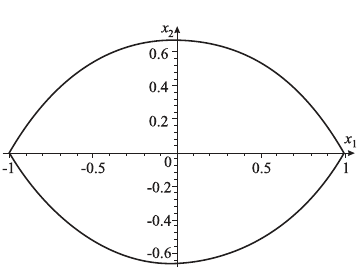
Fig. 3. Cross section of the (cid:12)gure in the Ox 1 x 2 plane.